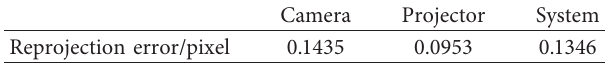
Figure 5: Schematic diagram of coordinate matching between the projector and the camera. Table 1: Reprojection error of camera pixels and projection pixels by our proposed method for Figure 5.